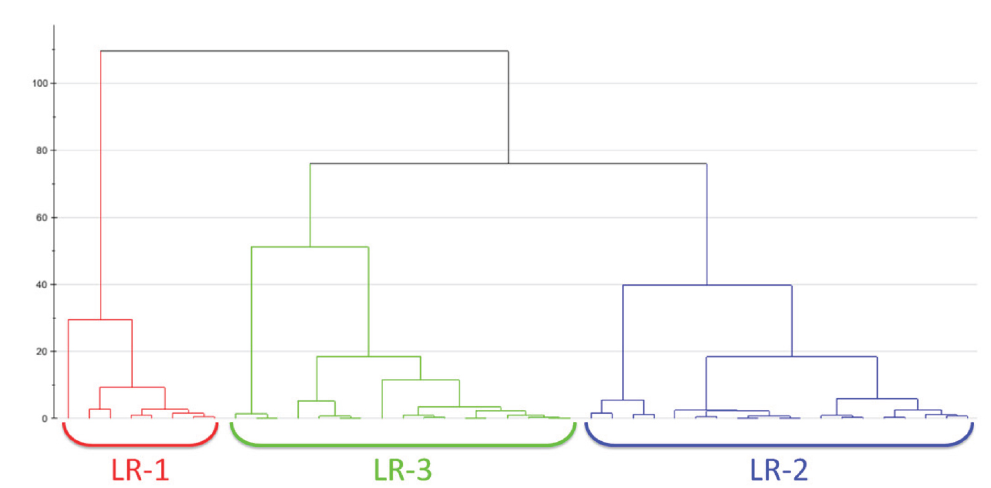
Figure 3. An example of a dendrogram obtained by means of hierarchical cluster analysis performed on 1 H NMR data on the plasma metabolome of 50 patients with early breast cancer. From the analysis, 3 different groups are classified: LR-1 (red), LR-2 (blue) and LR-3 (green). In this case, the Ward algorithm is adopted for measuring the distance. Figure reprinted from Ref. [48] under the terms of the CC-BY